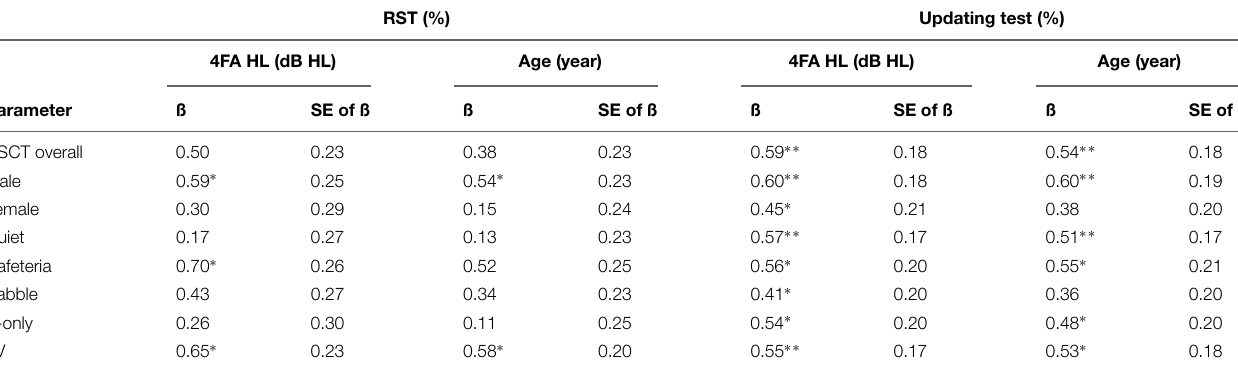
TABLE 3 | The standardized regression coefficients (ß) and their SE values related to the extent to which CSC scores are predicted by performance on the RST or updating test when controlling for degree of hearing loss (4FA HL) or